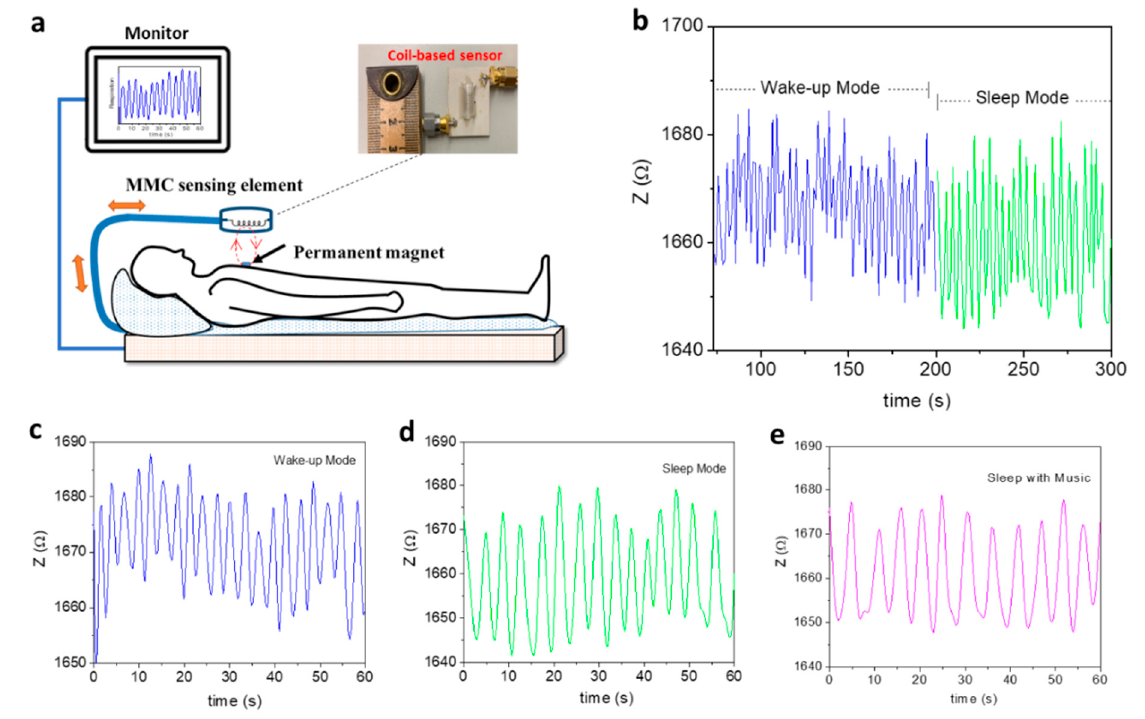
Figure 11. ( a ) Schematic for the respiratory motion test and results; inset is an image of the soft- magnetic-coil-based sensor probe; ( b ) breathing patterns of a 42-year-old patient were continuously tracked from waking to sleeping; ( c ) waking of the patient; ( d ) during sleep, the patient breathed more deeply (higher amplitude) and slowly (14 times per minute) than when awake (20 times per minute); ( e ) breathing patterns of this patient while sleeping with piano music; the person breathed more regularly and slowly (11 times per minute) than when sleeping without music (14 times per minute) ( d ). The abnormal breathing observed around 45 s almost disappeared when sleeping with music.